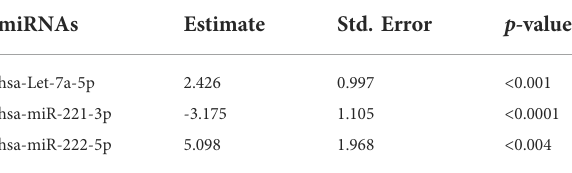
TABLE 2 Establishment of the predictive three-miRNA panel and to evaluate its ef fi cacy for diagnosis: univariate logistic regression analysis of candidate miRNAs. The statistical analysis was done using GraphPad Prism 5.0.